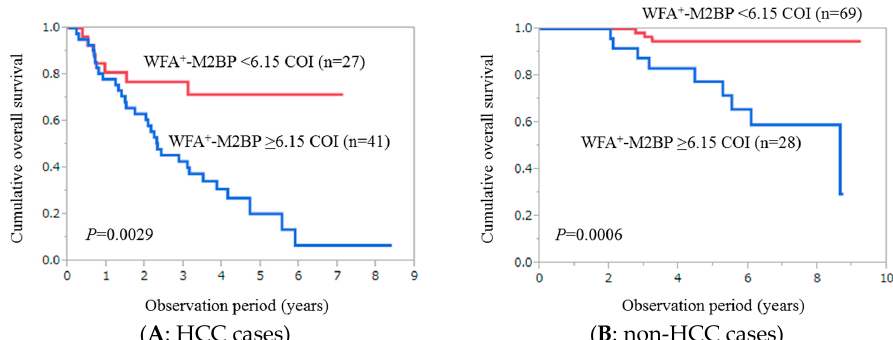
Figure 2. ( A ) Cumulative overall survival stratified by WFA + -M2BP for patients with hepatocellular carcinoma (HCC) ( n = 68). The cumulative one-, three- and five-year survival rates were 78.05%, 42.8% and 20.27%, respectively, in patients with WFA + -M2BP ≥ 6.15 COI ( n = 41), while 81.02%, 76.97% and 71.47%, respectively, in patients with WFA + -M2BP < 6.15 COI ( n = 27) ( p = 0.0026); ( B ) Cumulative overall survival stratified by WFA + -M2BP for patients without HCC ( n = 97). The cumulative one-, three- and five-year survival rates were 100%, 87.5% and 77.58%, respectively, in patients with WFA + -M2BP ≥ 6.15 COI ( n = 28), while 100%, 98.31% and 94.76%, respectively, in patients with WFA + -M2BP < 6.15 COI ( n = 69) ( p = 0.0006).